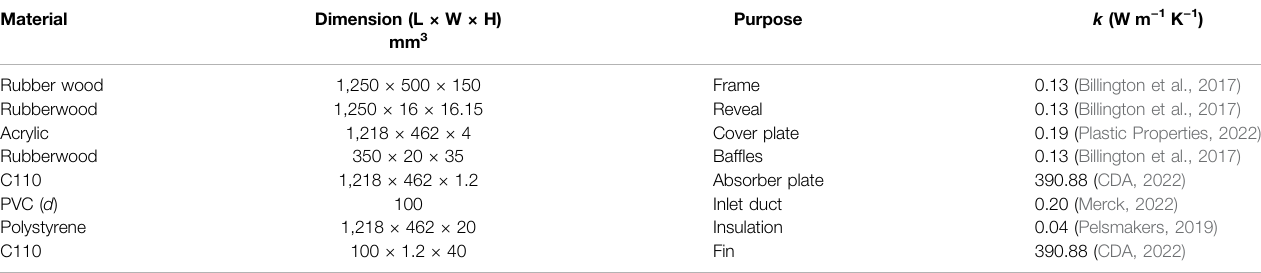
TABLE 1 | Constructional details along with thermal conductivities of materials used for solar air heaters. Material